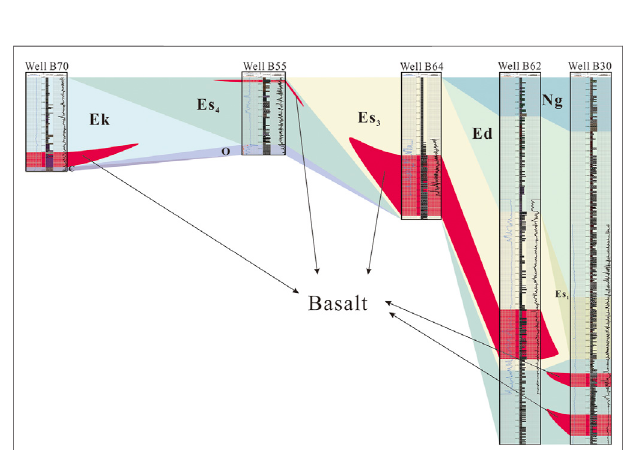
FIGURE 6 | The pro fi le of igneous rocks distribution in the northern side of Baxian Sag.